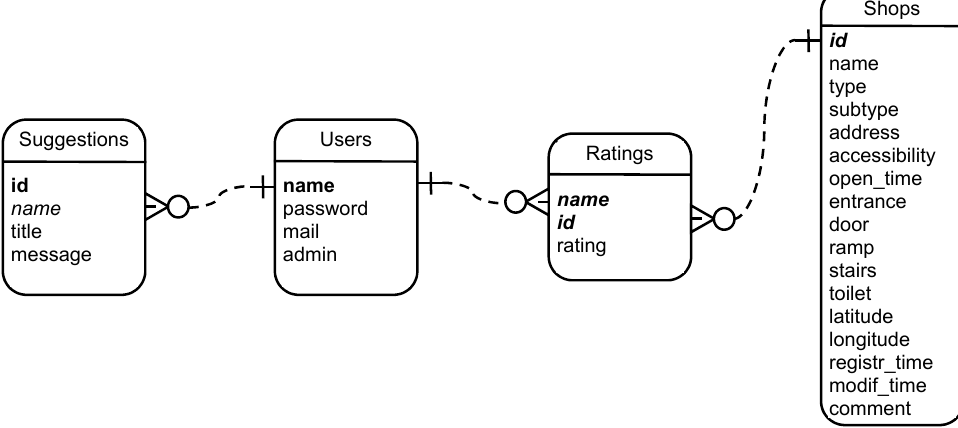
Figure 4. Entity-relationship diagram of the information stored in the database.